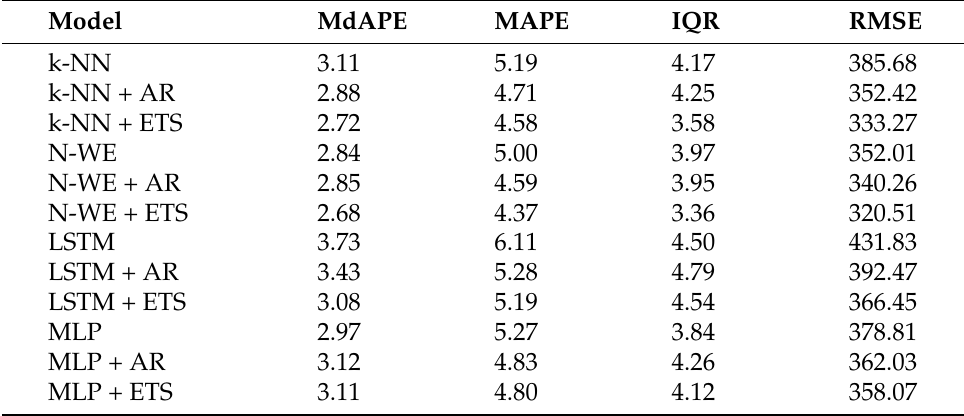
Table 2. Results comparison among proposed and comparative